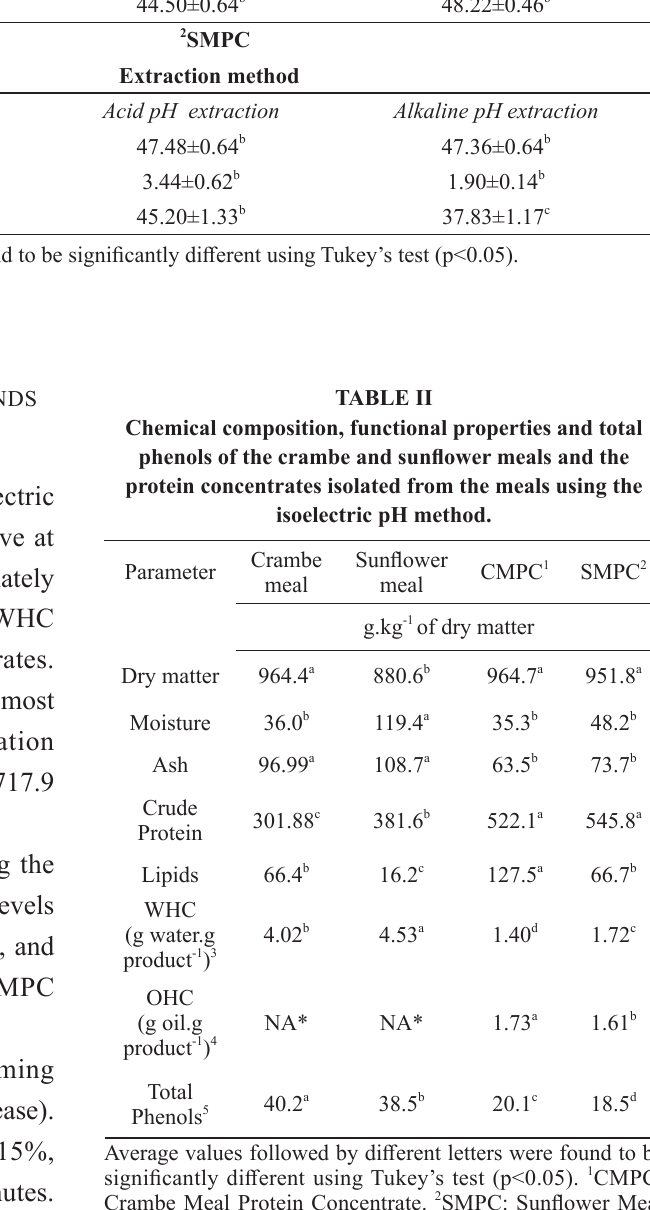
Crambe Meal Protein Concentrate. 2 SMPC: Sunflower Meal Protein Concentrate. 3 WHC: Water Holding Capacity: g